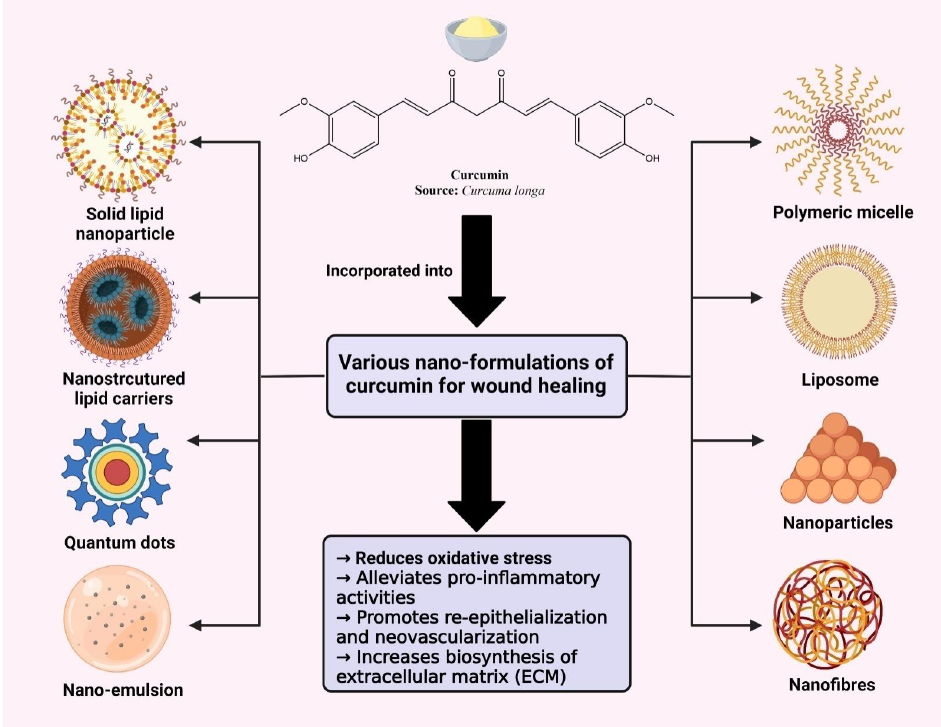
Figure 3. Applications of various topical formulations of curcumin for wound healing.